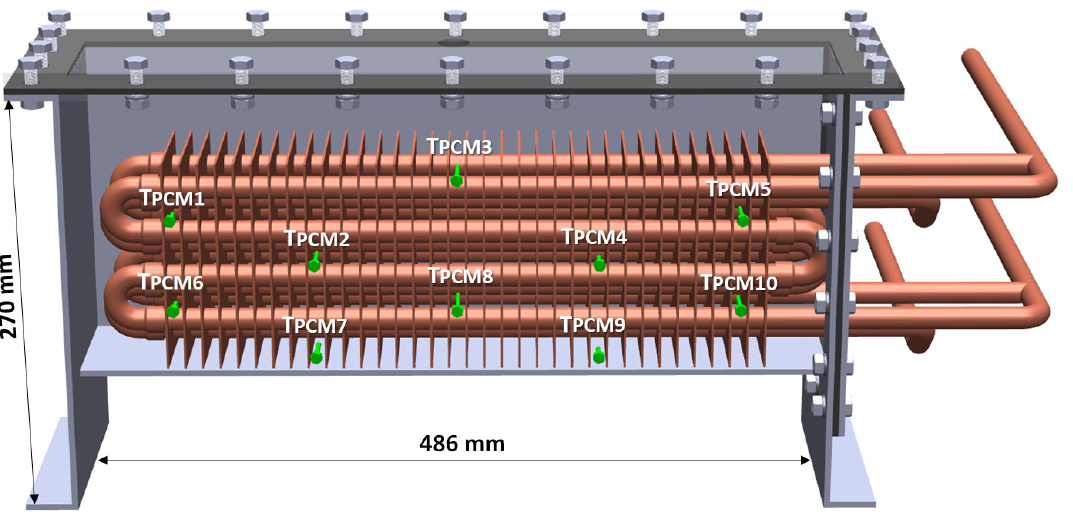
Figure 1. Schematic representation of the experimental setup (T PCM , T HW and T CW —temperature sensors; T1, T2—tanks for hot and cold water storage; EV1, EV2, EV3—expansion vessels; H—hot water heater, C—cold water cooler; V1—mixing valve with electronic constant temperature controller; V2–V6—manual valves; MF1, MF2—flowmeters; P1, P2—circulat- ing pumps).